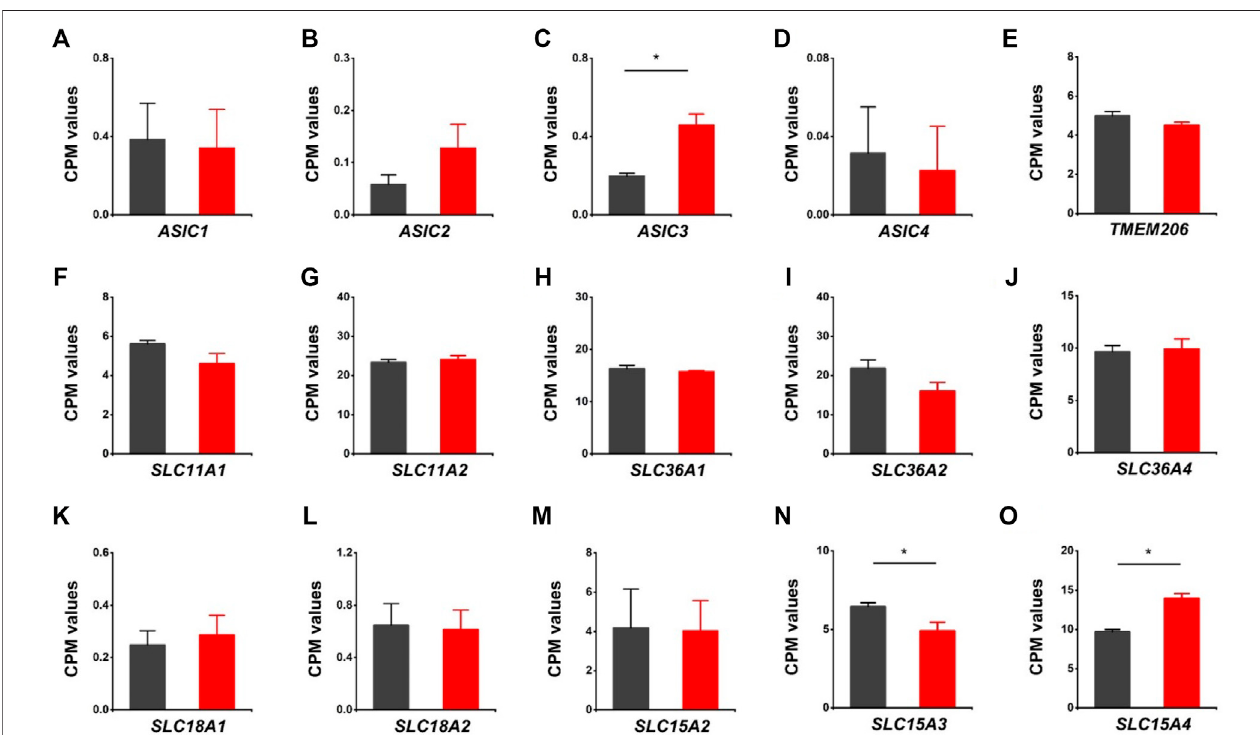
FIGURE 5 | Differentially expressed genes related to proton-coupled channels/transporters/antiporters in HVCN1 − / − hearts. Comparing relative gene expression levelsofproton-coupledtransportersbetweenWT(black)andHVCN1 − / − (red)includingacid-sensingionchannels ASIC1,ASIC2,ASIC3,ASIC4 (A-D) ,protonactivated chloride channel TMEM206 (E) , proton-coupled metal-ion transporters SLC11A1 , SLC11A2 (F-G) , proton-coupled amino acid transporters SLC36A1 , SLC36A2 , SLC36A4 (H-J) , proton/amine antiporters SLC18A1 , SLC18A2 (K-L) , and proton-dependent oligopeptide transporters SLC15A2 , SLC15A3 , SLC15A4 (M-O) . n = 4 independent experiments for RNA-seq; * p <